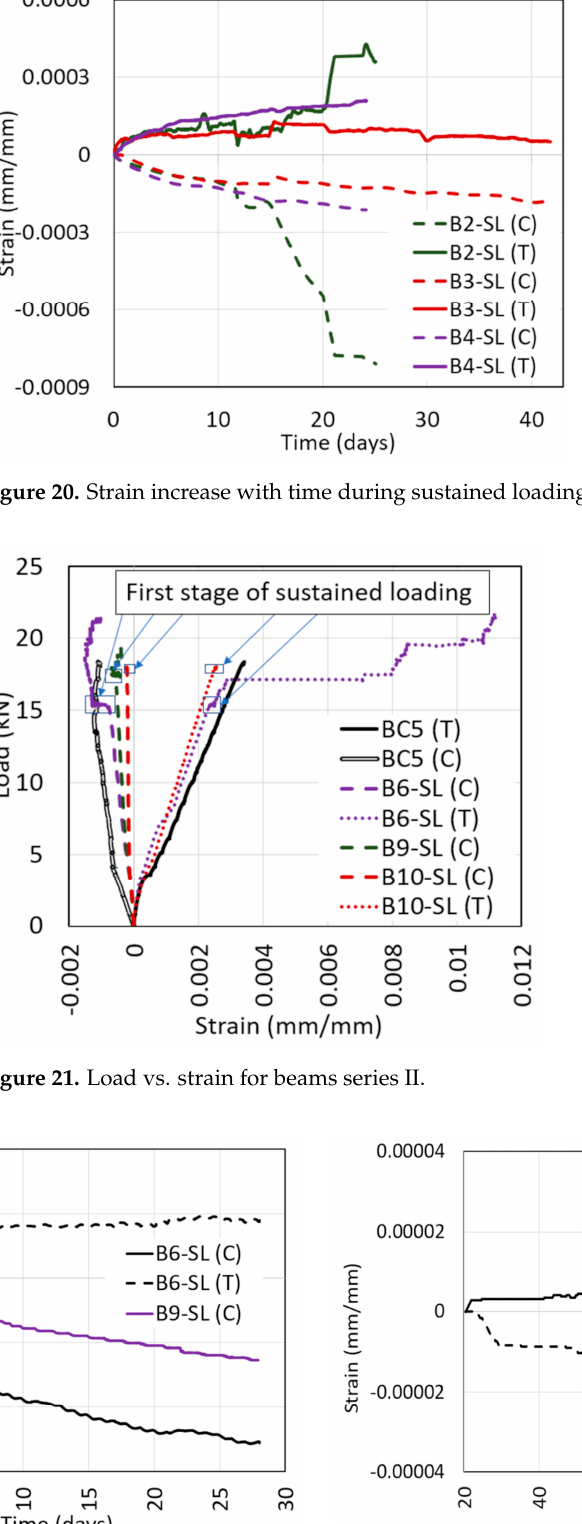
Figure 19. Load vs. strain for beams series I.